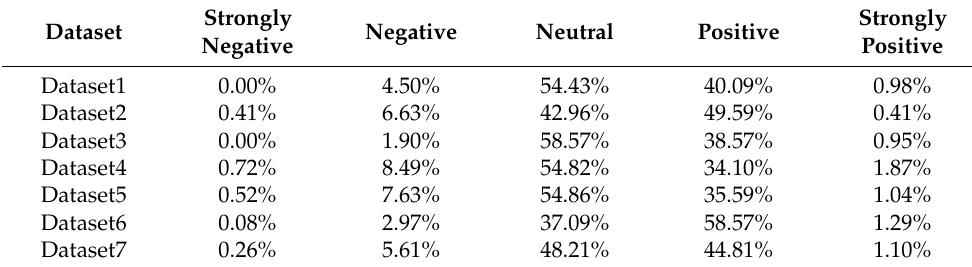
Table 3. Percentage of sentiment analysis result based on